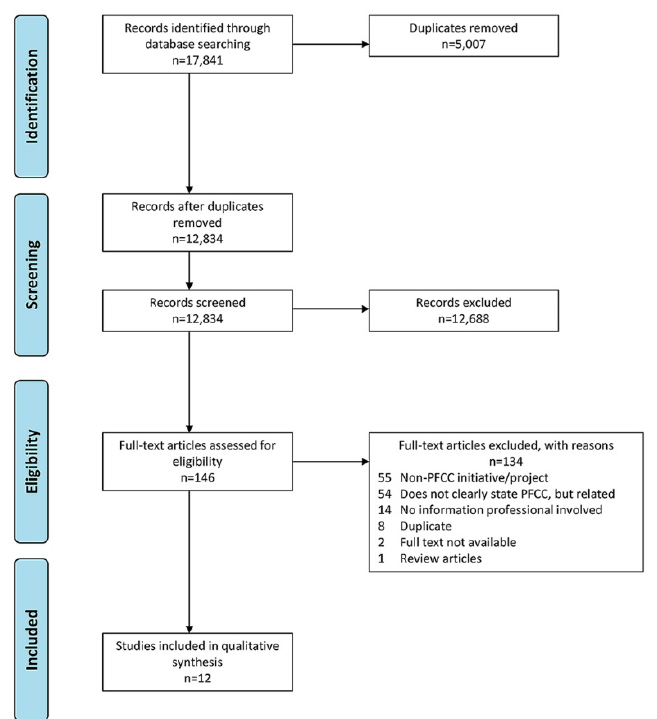
Figure 1 PRISMA flow diagram